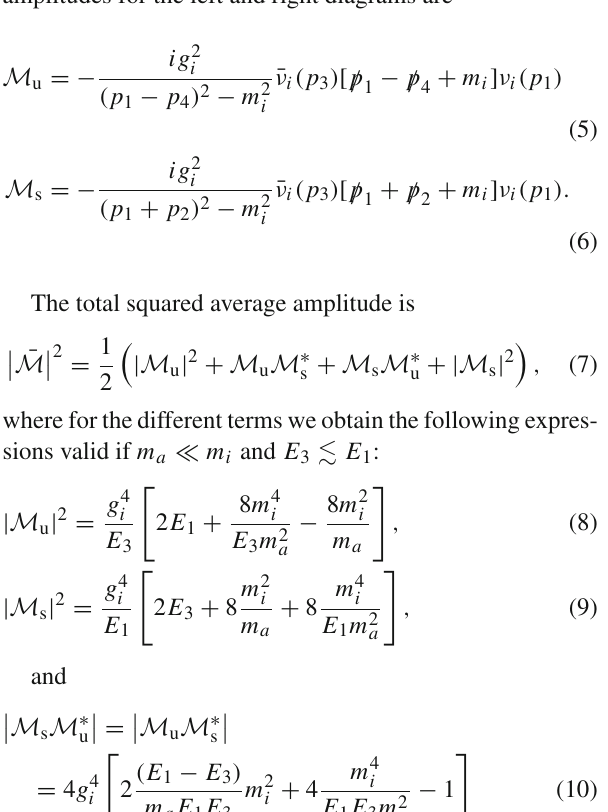
The possible interaction channels for neutrinos